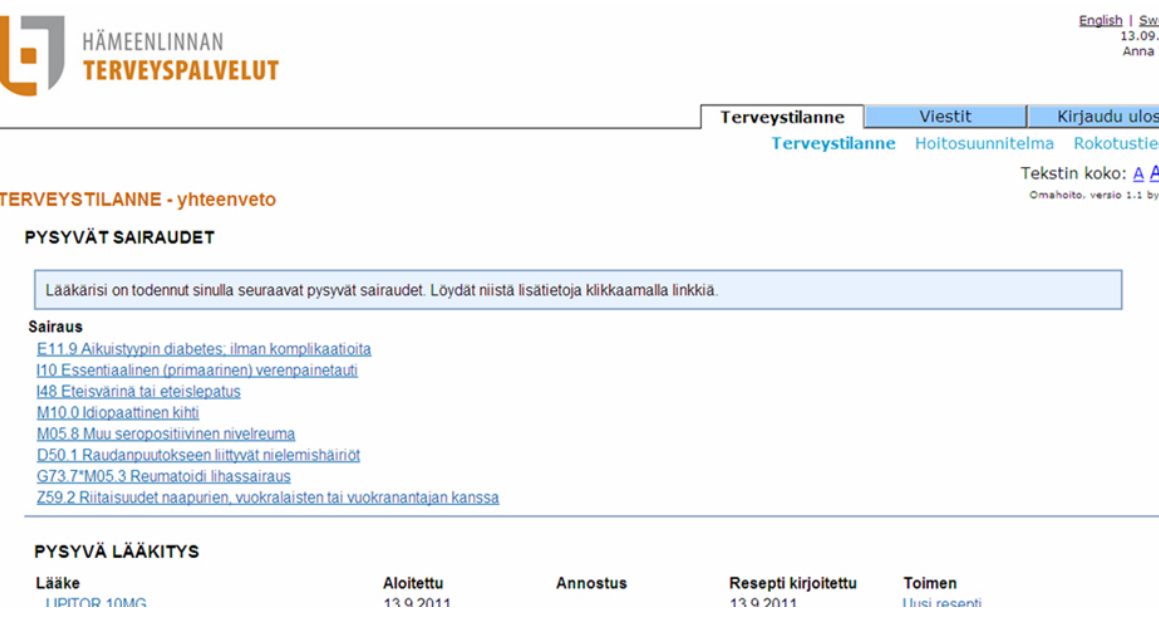
Figure 2. Screenshot of the patient